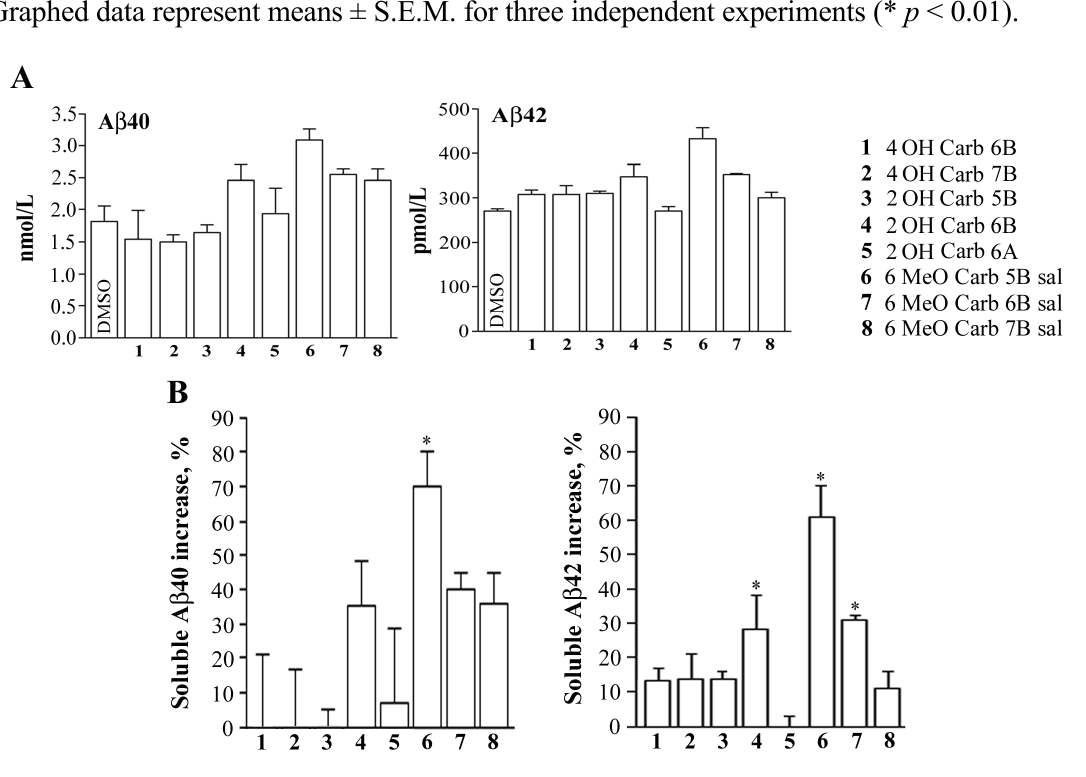
Figure 4. Effect of N -alkyl carbazole derivatives on soluble A β peptides in neuronal cell cultures. Conditioned media of N2a cells treated for 16 h with the indicated compounds (10 μ M) were subjected to A β 40 and A β 42 specific ELISA. Results are expressed in terms of soluble A β concentration ( A ) and percentage increase versus DMSO-treated samples ( B